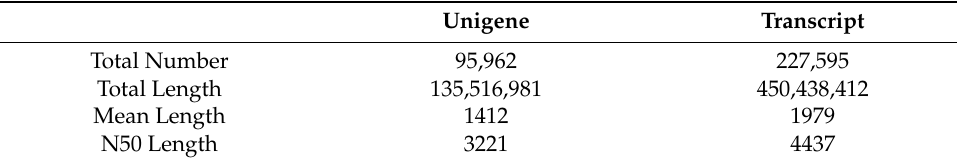
Table 1. Summary of de novo sequence assembly for Chinese hwamei.